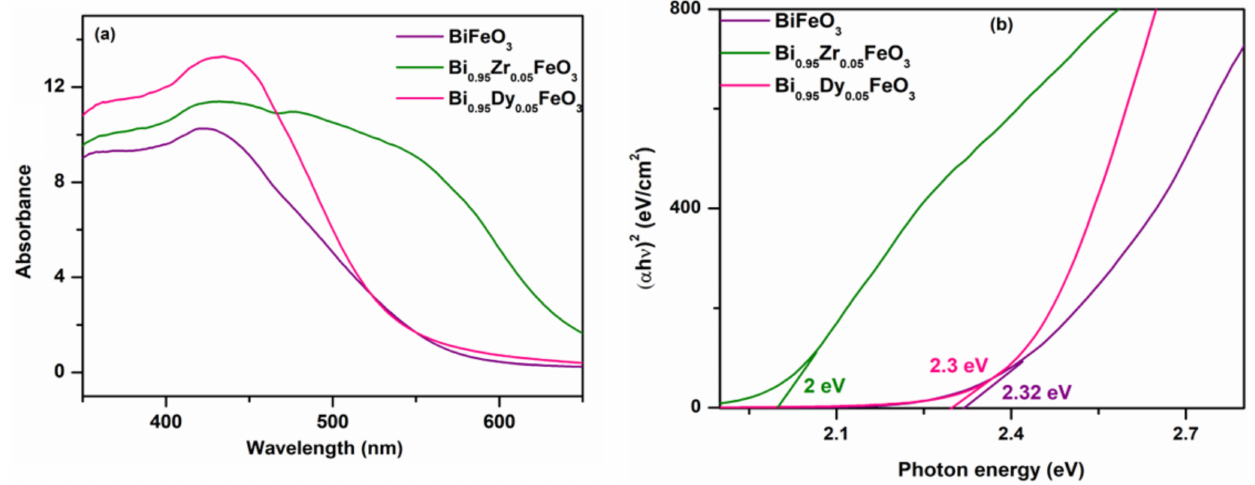
Table 1. Lattice constant, bond length, and dislocation density of BFO, BDFO, and BZFO thin films.